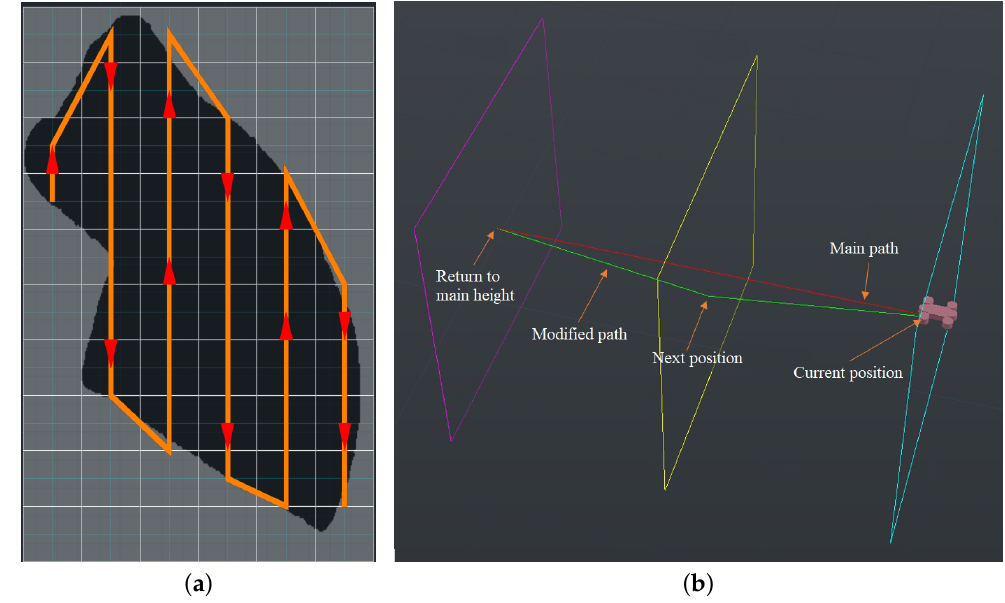
Figure 2. Illustration of the top and frontal views. ( a ) top view: a binary image representing an area of interest [14]: black cells are obstacles, grey cells are free areas; ( b ) example of a frontal view with obstacle. The red line is the original path and the green one is the new